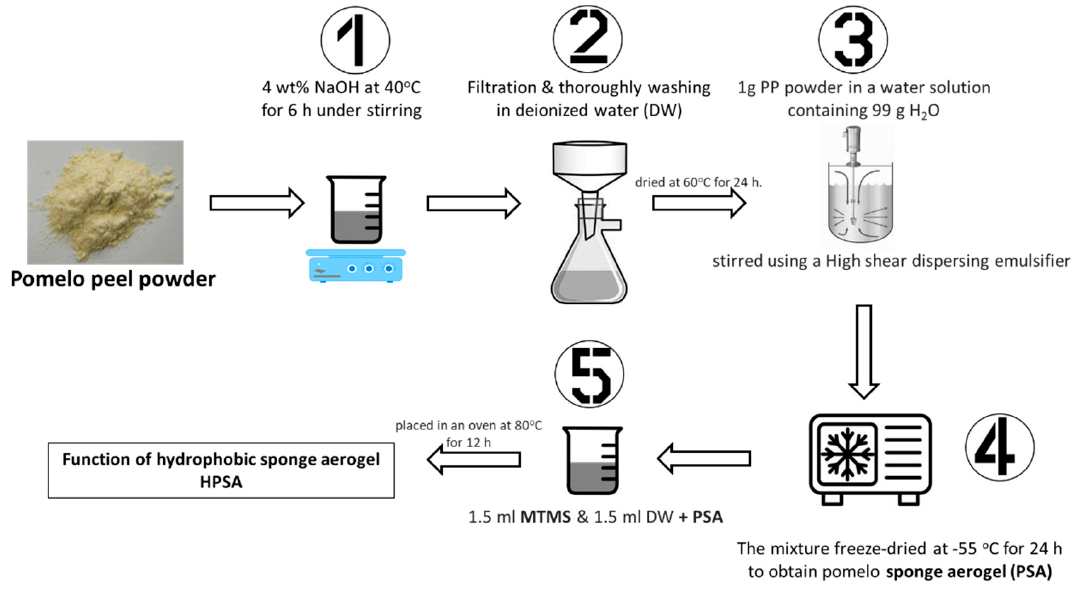
Figure 9. Preparation of hydrophobic sponge aerogels based on pomelo peel powder (based on information from [85]).